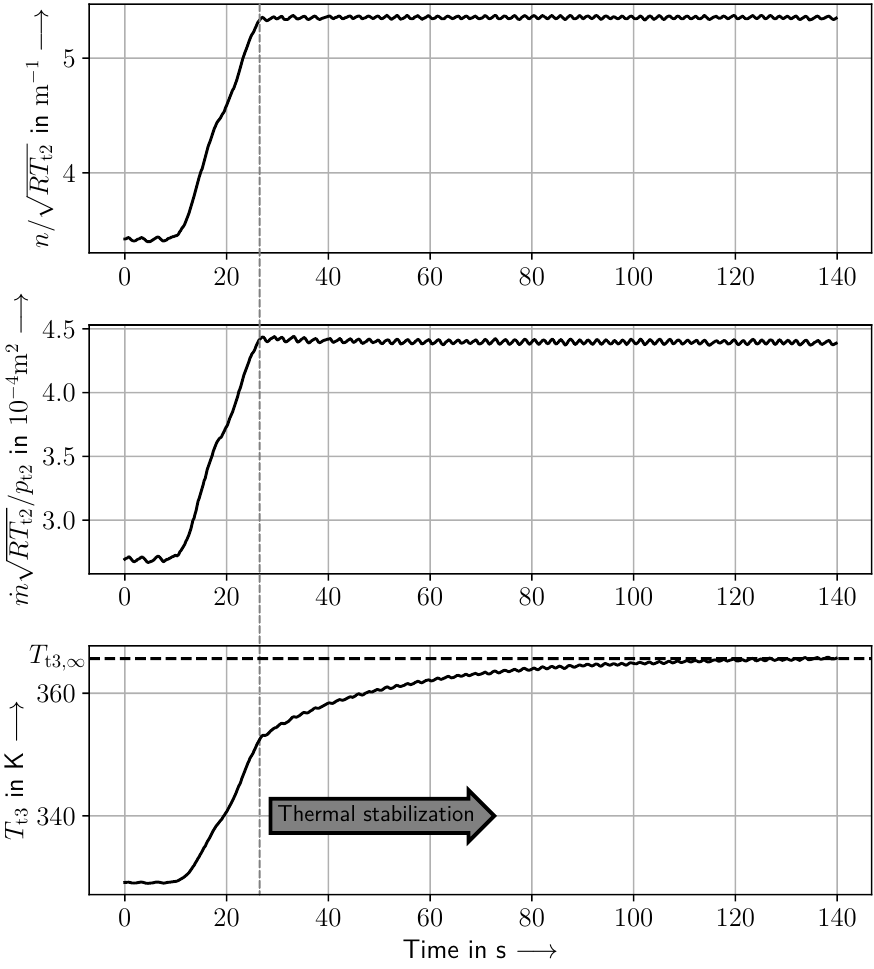
Figure 9. Compressor data for a typical acceleration